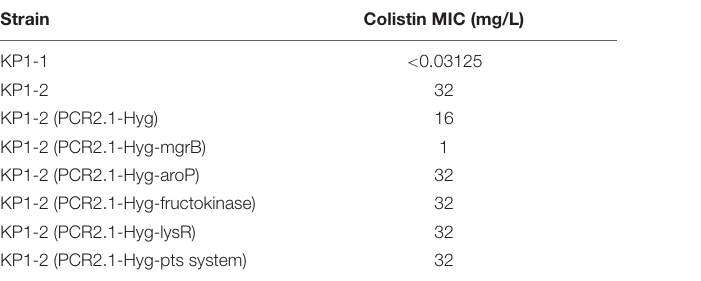
TABLE 4 | The transformants of differential genes and the corresponding MICs of colistin. Strain Colistin MIC (mg/L) KP1-1 <